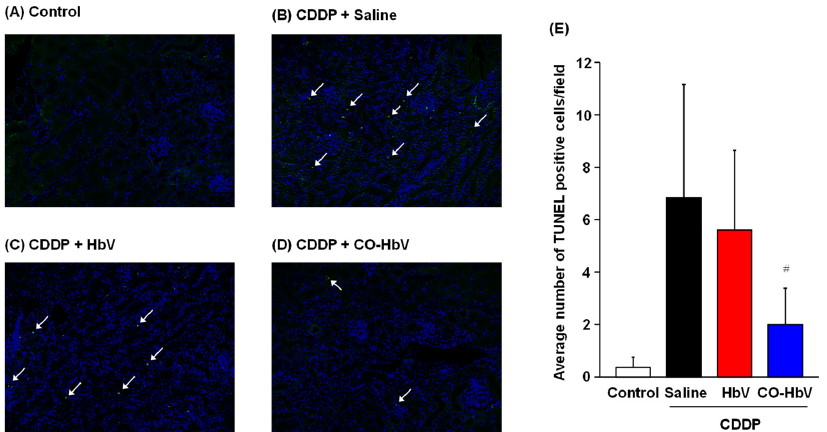
Figure 3. Representative TUNEL image of kidney at 96 h after each sample treatment in cisplatin (CDDP) mouse model. ( A ) Control mice (without CDDP treatment), CDDP mouse model treated with ( B ) saline, ( C ) Hemoglobin-vesicle (HbV), and ( D ) carbon monoxide (CO)-loaded HbV (CO-HbV). The images shown as merged images of TUNEL-positive cells (green) and DAPI staining (blue) (200× magnification). ( E ) Quantitative image analysis of TUNEL (green) and DAPI (blue) positive cells (white arrows). The data represents the mean ± S.D. Control ( n = 8), Saline ( n = 7), HbV ( n = 8), CO-HbV ( n = 8); # p < 0.05 vs. Saline .